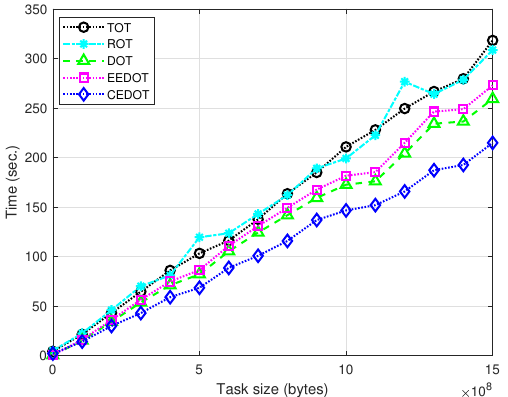
Figure 3. Service delay for different task